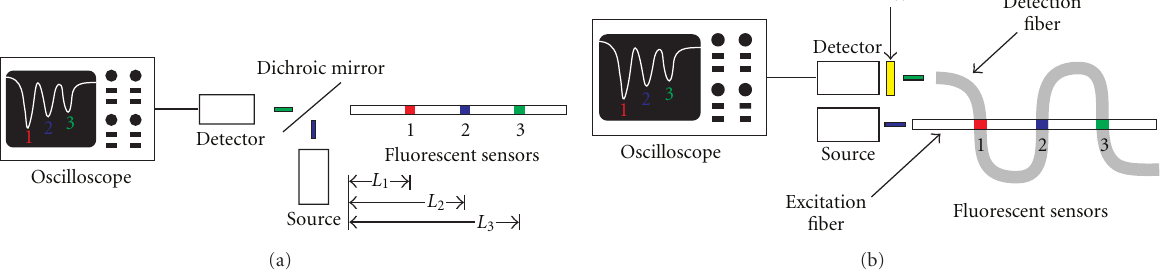
Figure 1: Illustration of optical time-of-flight detection (OTOFD) with (a) the single fiber scheme and (b) the crossed-fiber scheme.